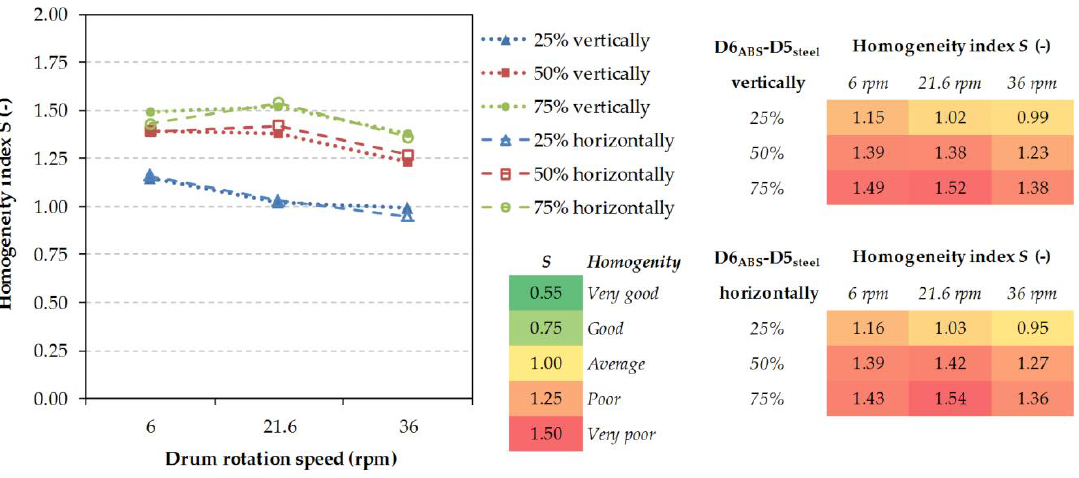
Figure 14. Resulting homogeneity indices for different operating conditions (D6 ABS – D5 steel particles).